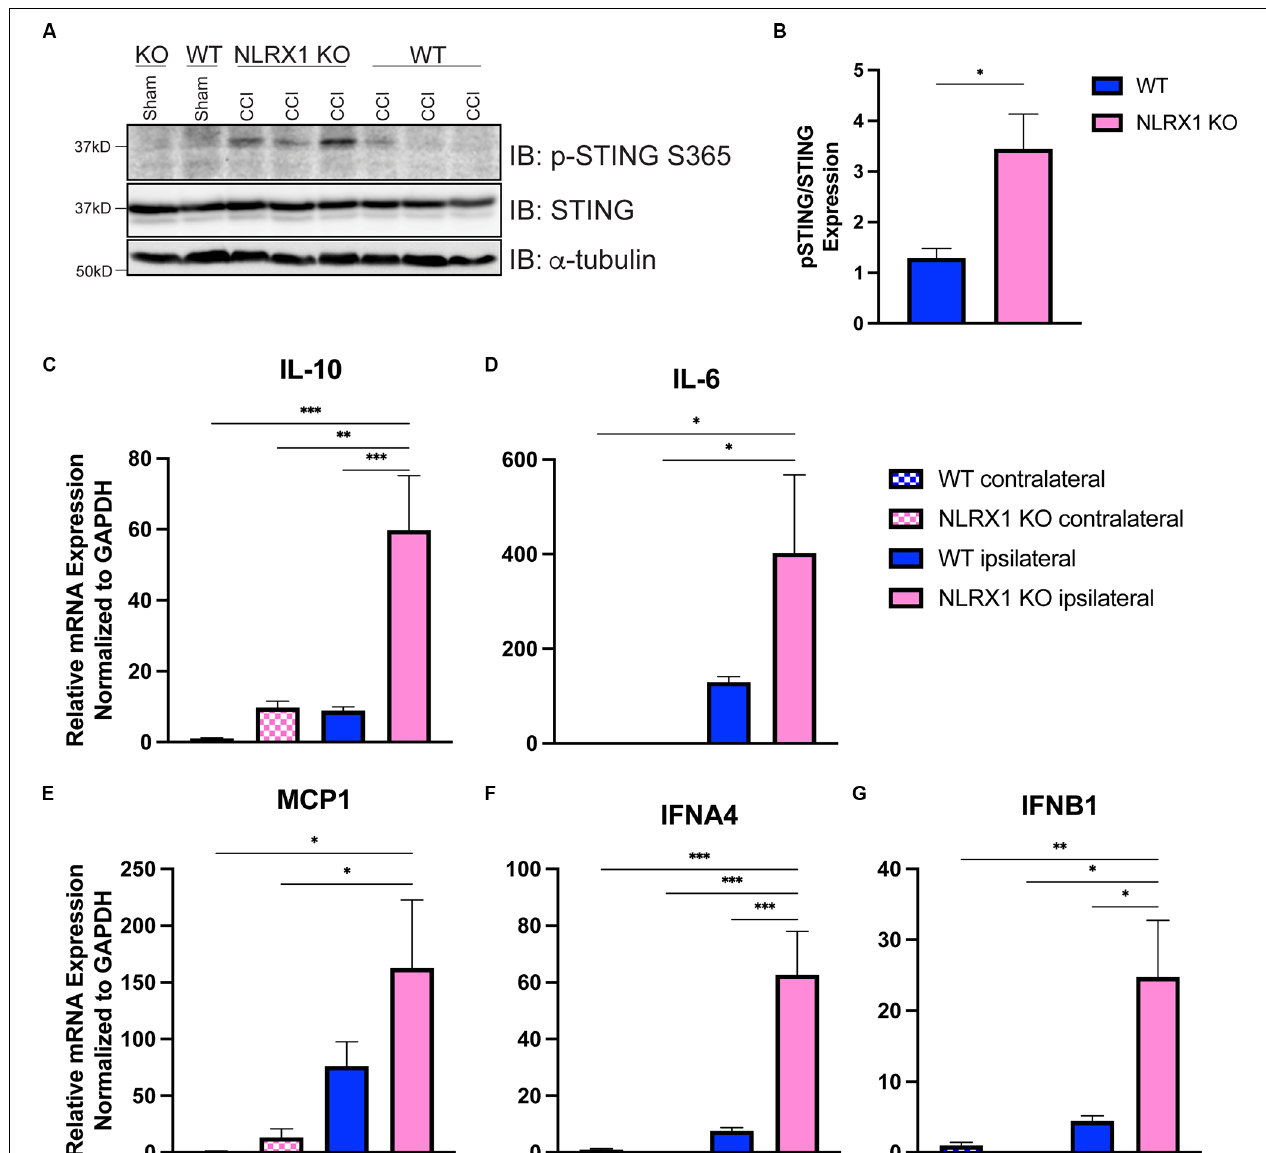
FIGURE 6 | NLRX1 negatively restricts cGAS-STING activation after injury. (A) Representative western blotting of phosphorylated STING, STING, and alpha tubulin in WT and NLRX1 KO cortical tissue 3 days post-injury or sham surgery. (B) Quantification of pSTING/STING, normalized to alpha tubulin shown in (A) . mRNA expression of (C) Il10 , (D) Il6 , (E) MCP1 , (F) IFNA4 , and (G) IFNB1 assessed by qPCR at 24 h post-injury in wildtype and NLRX1 − / − cortices. Gene expression normalized to GAPDH. n = 5–7 per group. Data presented as mean ± SEM. ∗ p < 0.05, ∗∗ p < 0.01, ∗∗∗ p <